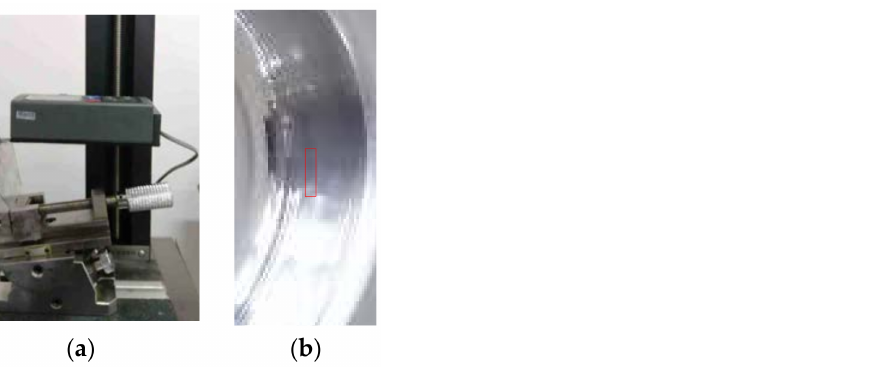
Figure 27. The roughness measurement: ( a ) measurement process and ( b ) measurement area.